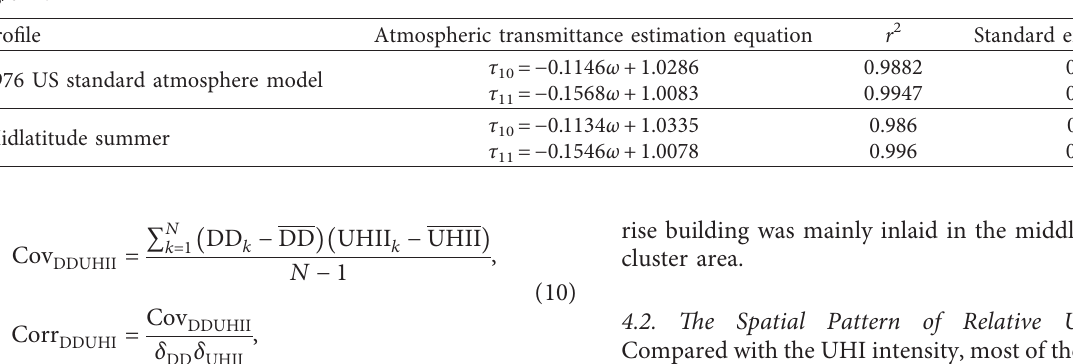
Table 1: Inversion regression coefficients of TIRS in different temperature ranges ( r 2 Temperature range ( ° C)